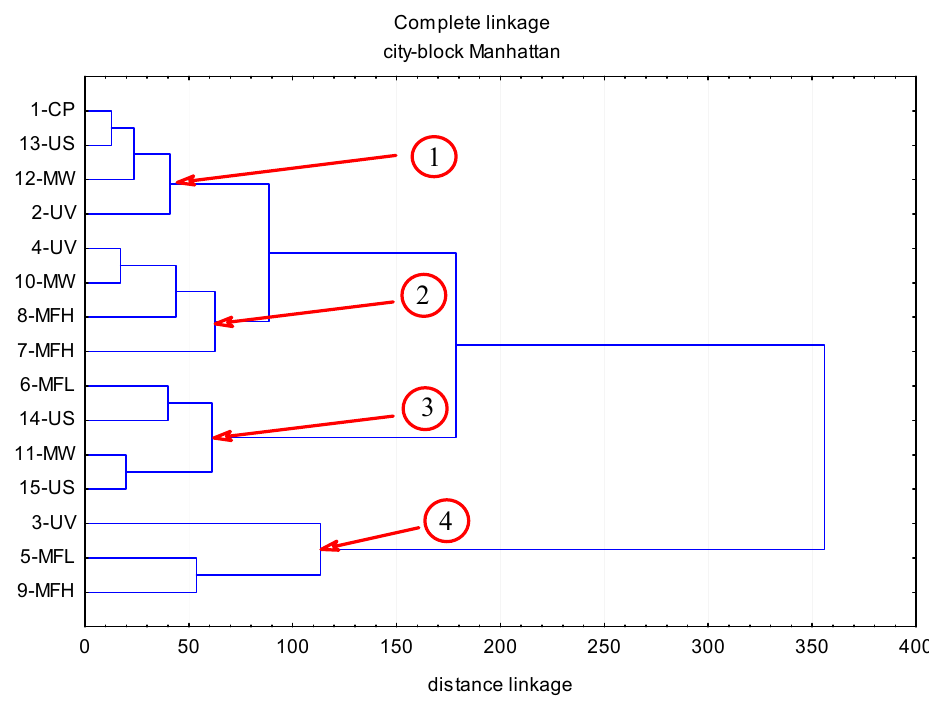
Figure 4. The influence of abiotic stress factors (UV-C electromagnetic field of the microwave field, ultrasound) on the content of flavan-3-ols in chokeberry fruits.